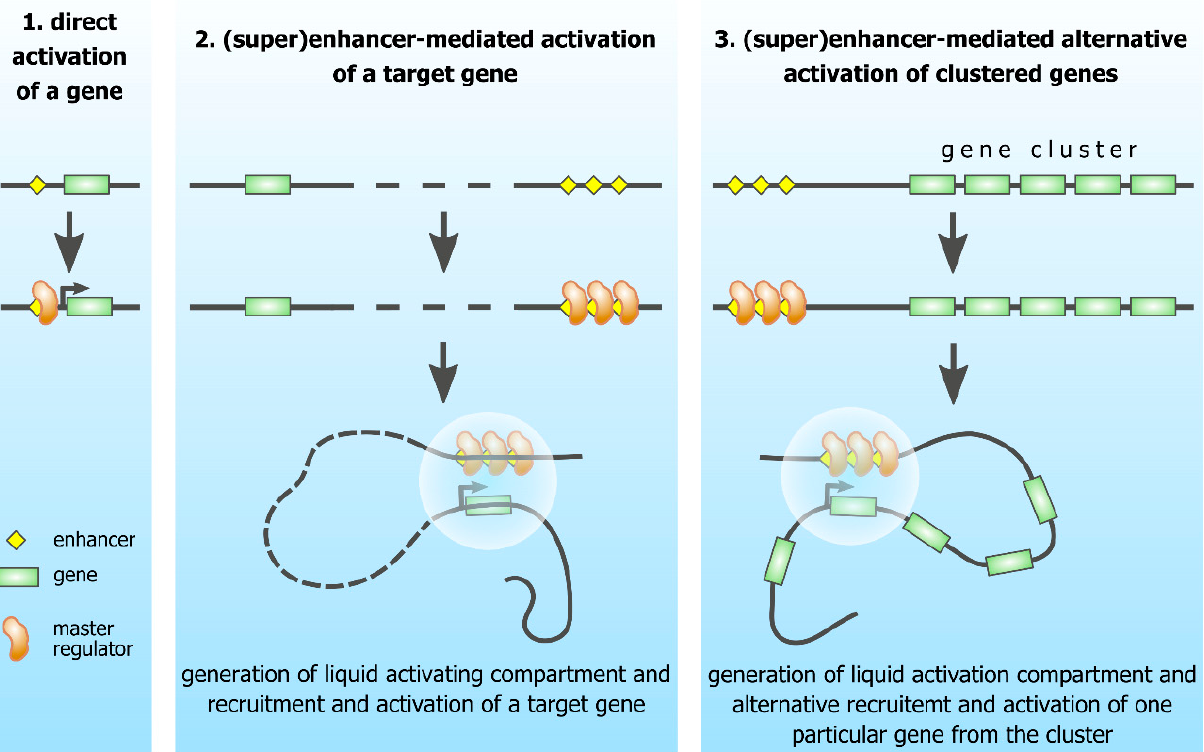
Figure 2. Strategies of transcriptional control of dispersed and clustered tissue-specific genes.